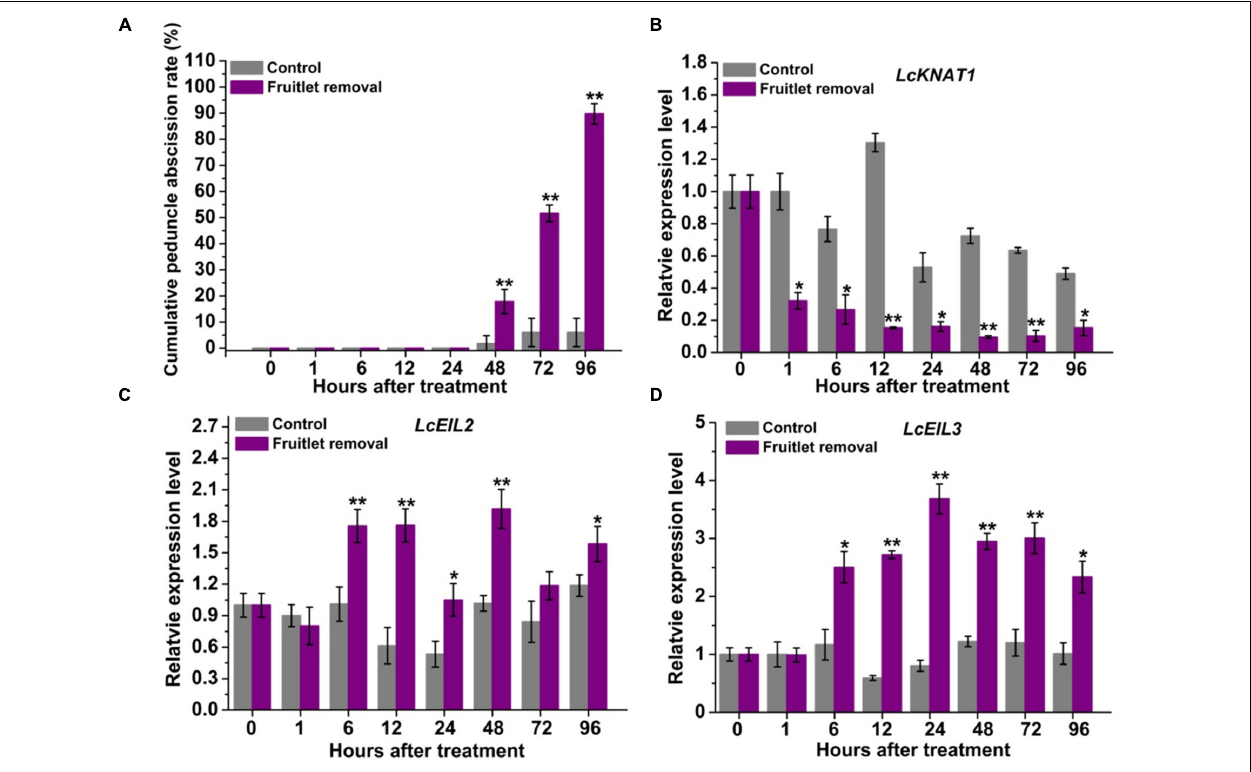
FIGURE 1 | LcKNAT1 is decreased, but LcEIL2 / 3 expression is increased in the abscission zone (AZ) during the fruitlet removal-induced abscission process in litchi. (A) Fruitlet removal induced the peduncle abscission. The expression patterns of LcKNAT1 (B) , LcEIL2 (C) , and LcEIL3 (D) after fruitlet removal. SE comes from three replicates. Asterisks indicate a significant difference (Student’s t -test: * P < 0.05, ** P < 0.01).